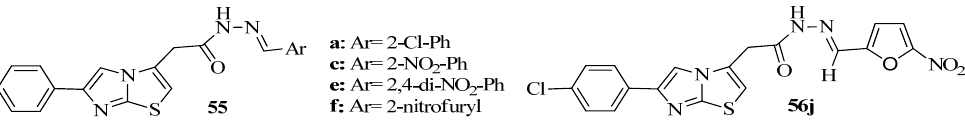
Figure 21. Structures of N’ -(arylidene)-2-[6-(4-bromophenyl) imidazo[2,1- b ]thiazol-3- yl]acetohydrazides.